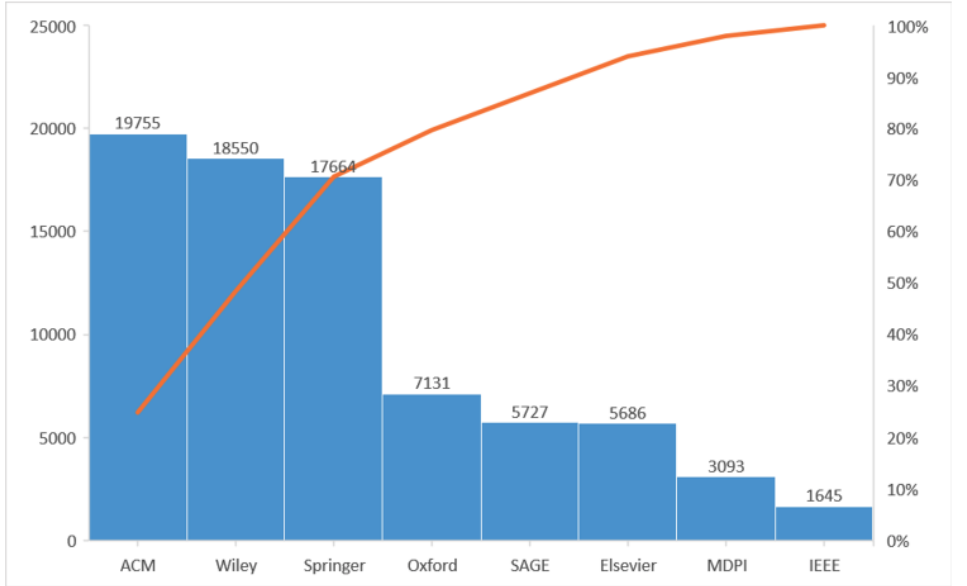
Figure 4. Number of articles that appeared in major scientific libraries accessible to a researcher, presented in decreasing order from January to December 2020. The orange line displays the cumulative %, demonstrating that only three major scientific libraries (ACM, Wiley, and Springer) contributed about 70% of the articles. ACM: Association for Computing